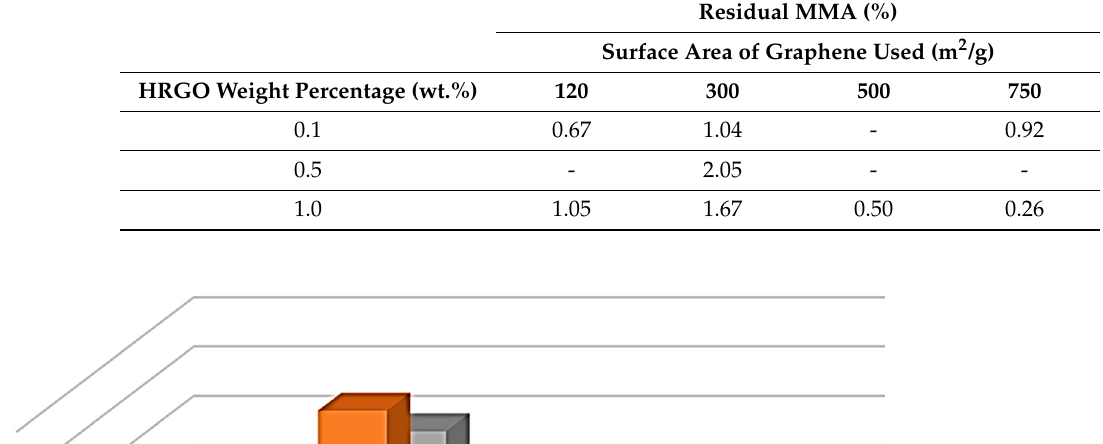
Table 6. Residual monomer MMA (%) versus the percentage and surface area of the added HRGO.